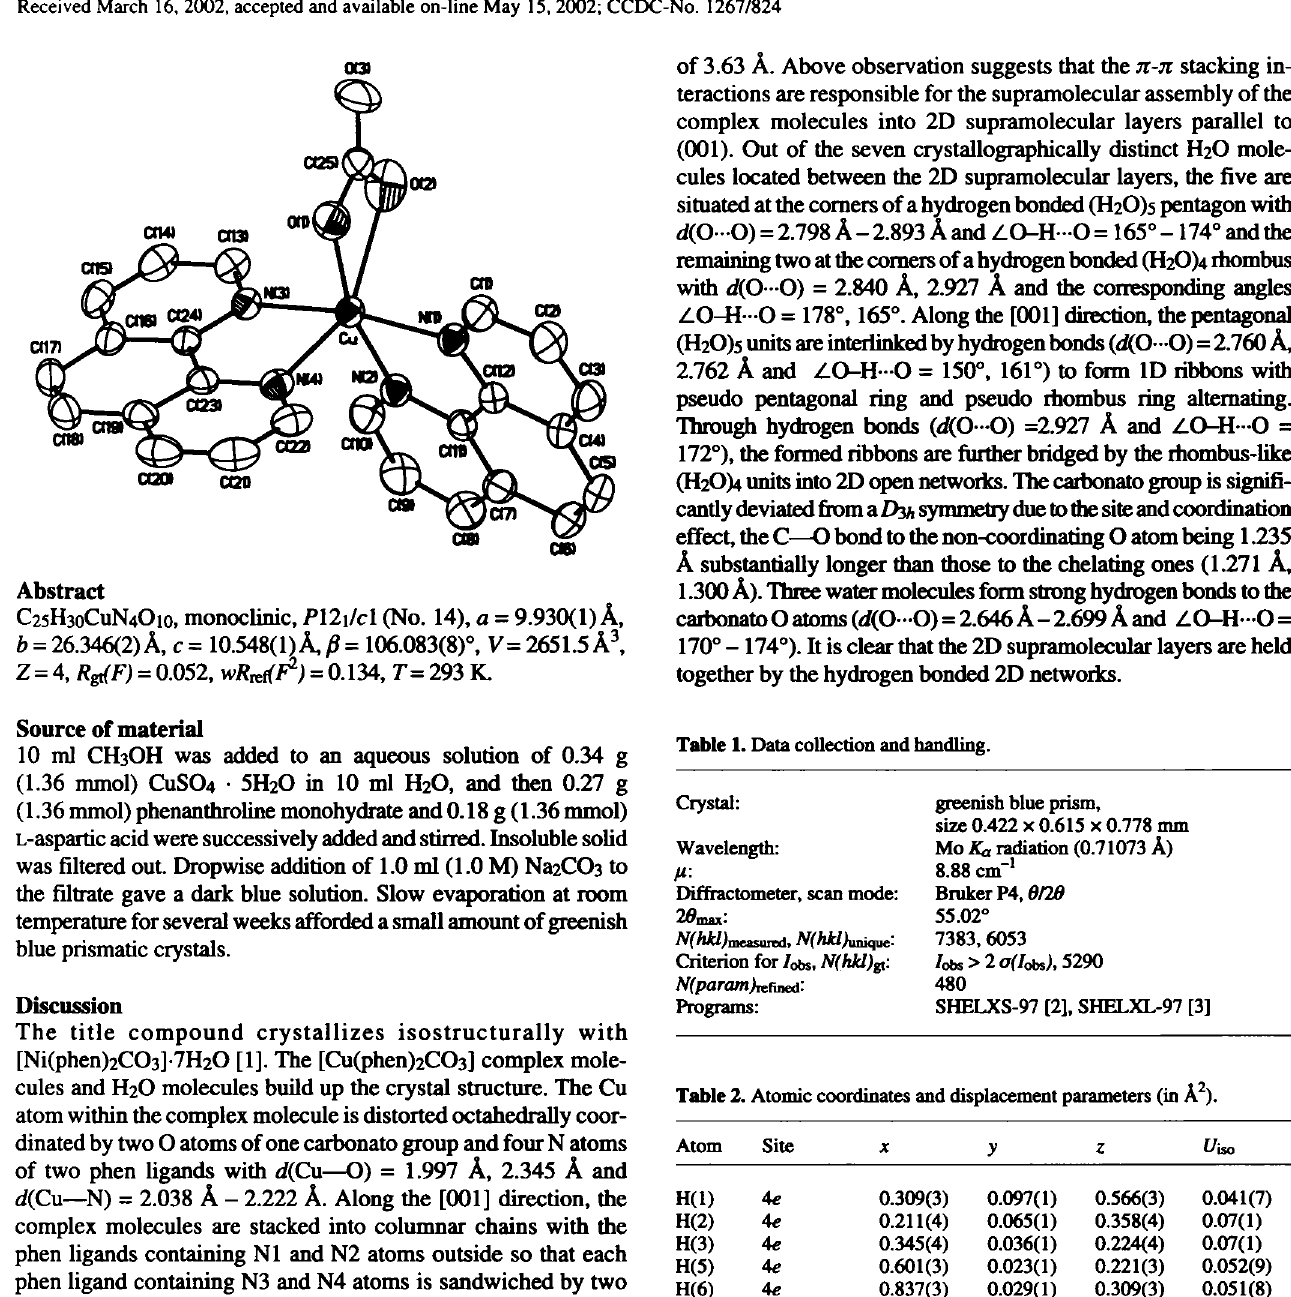
Table 2. Atomic coordinates and displacement parameters (in Â 2